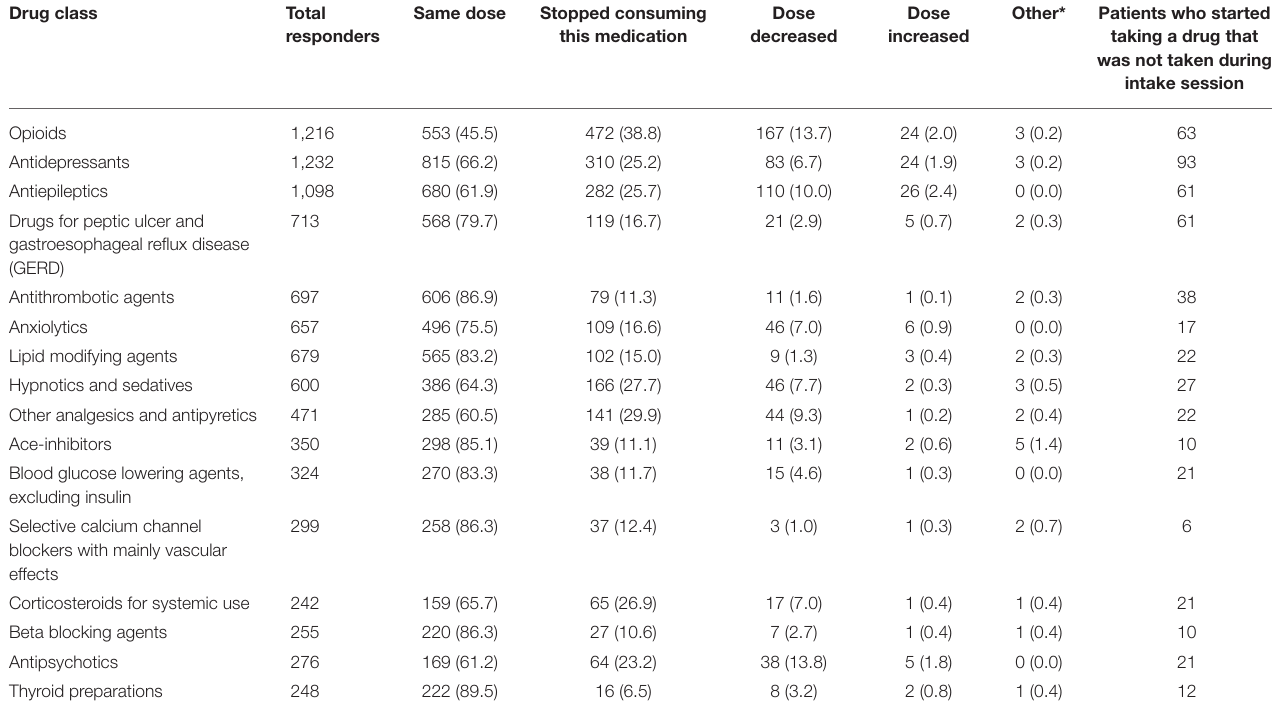
TABLE 6 | Prescription medication use at 6 months follow-up. Drug class Total